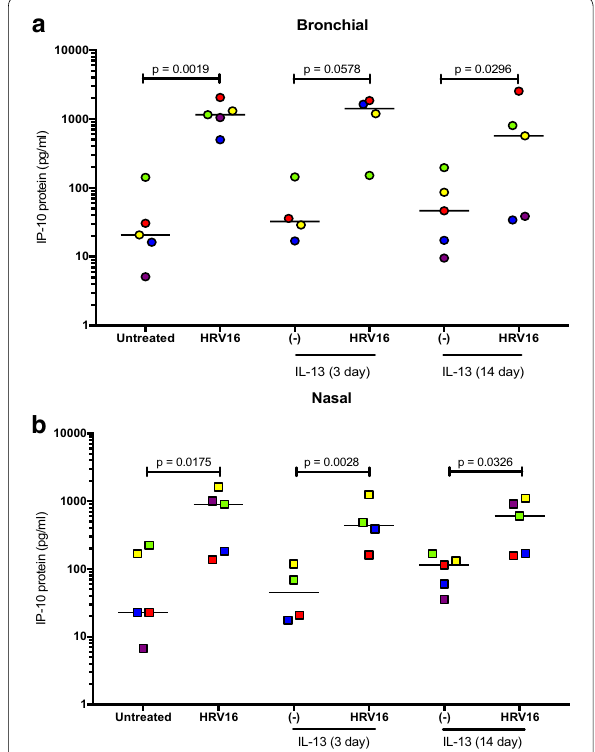
Fig. 3 Human rhinovirus 16 (HRV16) infection increases IP-10 in paired human primary bronchial ( a ) and nasal ( b ) epithelial cells cultured at air–liquid interface (ALI). Each of the colored solid circles (n 4–5 subjects) represents the data from an individual subject. The = horizontal lines indicate